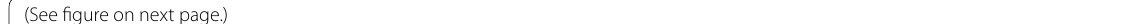
(See figure on next page.) Fig. 5 GC analysis of crude oil degradation in culture of Pseudomonas sp. ZS1 in presence or absence of Alcaligenes sp. CT10. a GC analysis